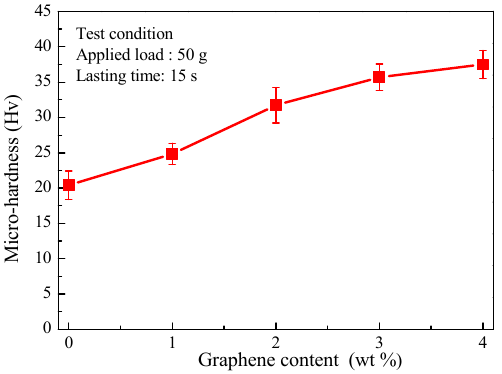
Figure 2. Effect of graphene content on the micro-hardness of the polymer composite coatings.